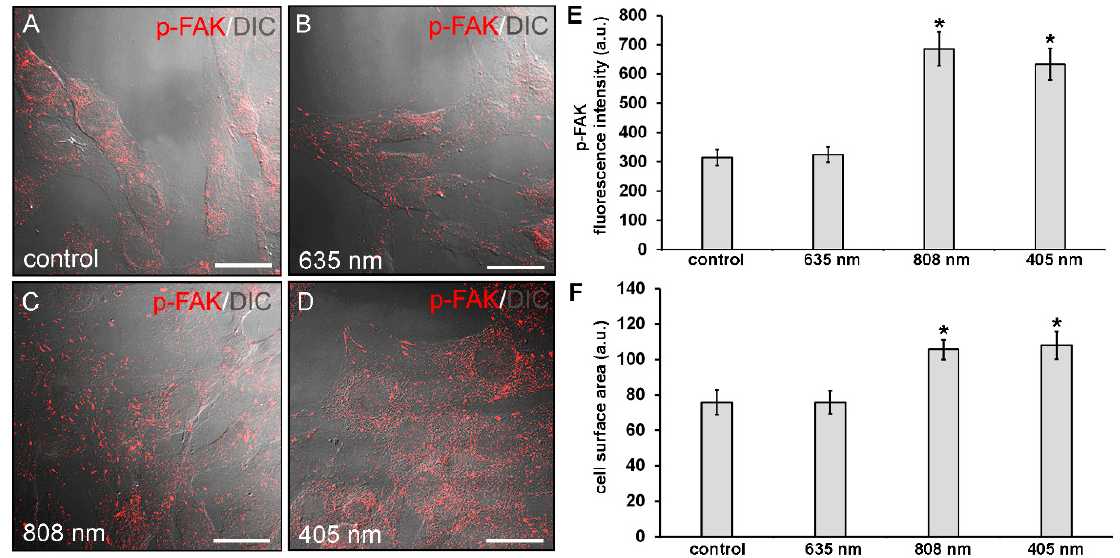
Figure 4. Confocal immunofluorescence analysis of p-FAK expression in NIH / 3T3 fibroblasts performed 24 h after cell exposure to red (635 nm), NIR (808 nm) and violet-blue (405 nm) PBM. Cells not subjected to PBM treatments served as control. ( A – D ) Representative superimposed di ff erential interference contrast (DIC) and confocal fluorescence micrographs simultaneously acquired of the cells immunostained for p-FAK (red) detection, showing the cellular localization of the protein. DIC images allow appreciating the di ff erent morphology of the cells subjected to PBM treatments. Scale bar: 30 µ m. ( E ) Histogram of the densitometric analysis of p-FAK fluorescence intensity performed on digitized images. Significance of di ff erence: * p < 0.01 vs control (808 nm, p = 0.0017; 405 nm, p = 0.0033); p = 0.89, 635 nm vs. control; p = 0.997, 405 nm vs. 808 nm. ( F ) Histogram showing the measure of cell surface area calculated on digitized DIC images by using ImageJ as indicated in Materials and Methods. Significance of di ff erence: * p < 0.01 vs. control (808 nm, p = 0.0098; 405 nm, 0.0051); p = 0.99, 635 nm vs. control; p = 0.89, 405 nm vs. 808 nm.